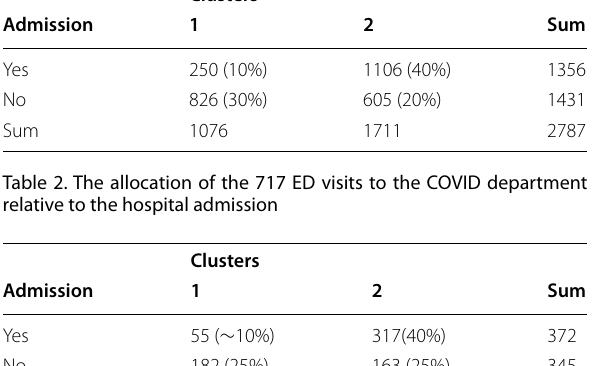
admission, is shown in Tables 1,2. Ideally, each row and each column of the tables would contain only one non-zero element. Table 1. The allocation of the 2787 ED visits to the Pneumonology department relative to the hospital admission Clusters